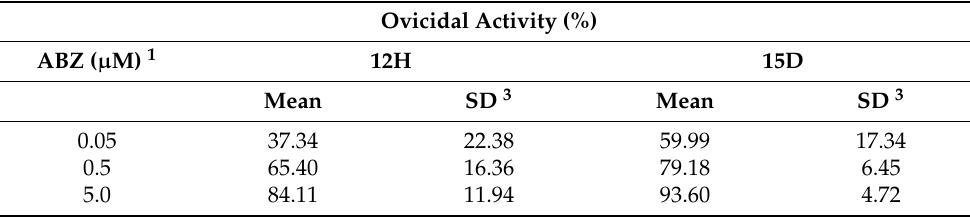
Table 2. Comparison of the mean ovicidal activity (%) of ABZ between the two versions of the EHT 2 .